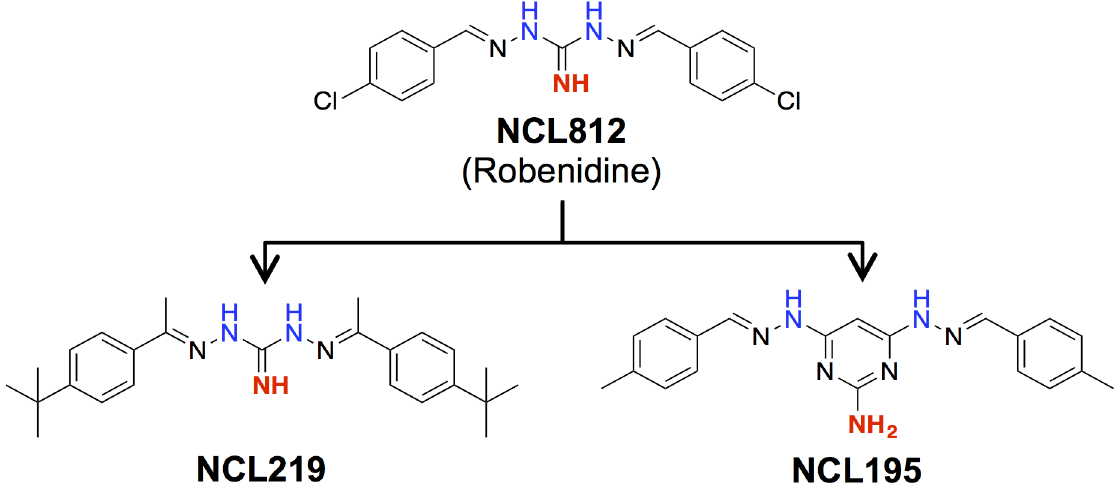
Fig 1. Structure activity relationship between NCL812, NCL195 and NCL219. Installationof a 4- tert -butyland a C-methyl imine moiety provided NCL219with considerablyenhancedhydrolyticstability whileretainingthe excellentantimicrobial activity of NCL812,while guanidineto 2,4,6-triaminopyrimindinebioisosteric modificationyieldedNCL195, which allowedpotency and drug-likecharacter enhancement.